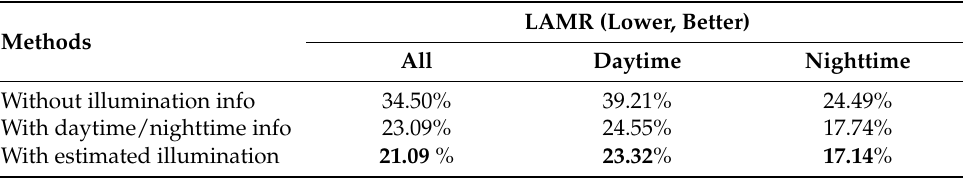
Table 4. Ablation study of illumination-aware label fusion. The results using known daytime/nighttime information to determine the fusion strategy are listed for comparison. When there is no illumination information available, the multispectral pedestrian detector generates pseudo labels and adapts itself accordingly. The best results are highlighted in